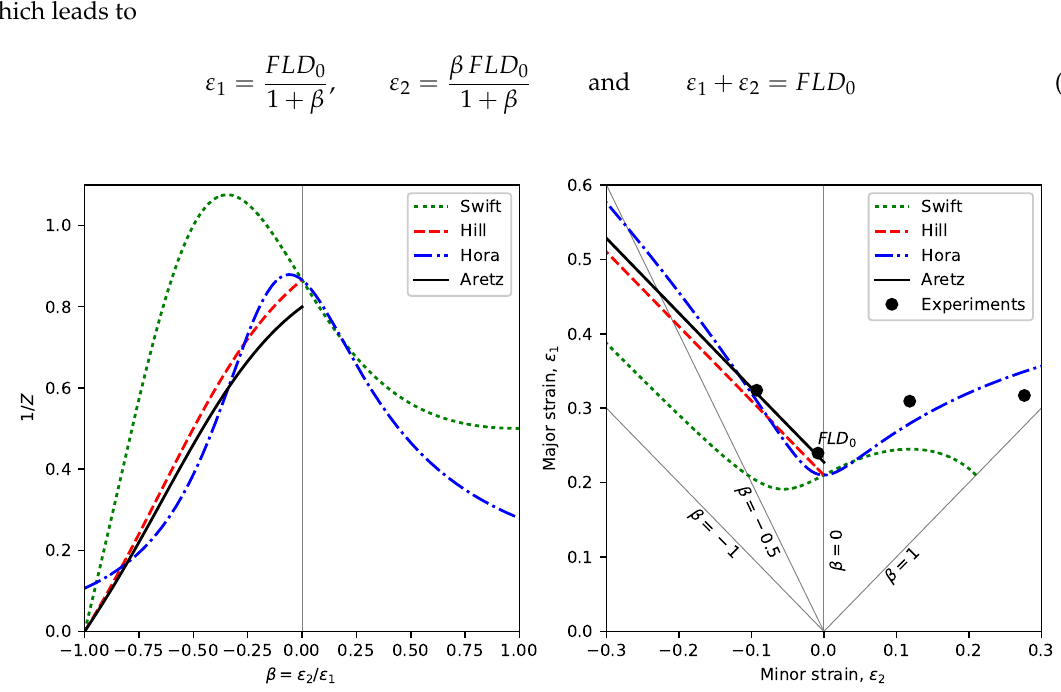
Figure 2. Necking predictions for AA7075-O sheets: ( a ) critical values of 1/ Z , and ( b ) forming limit diagram (FLD) with necking curves and experimental data